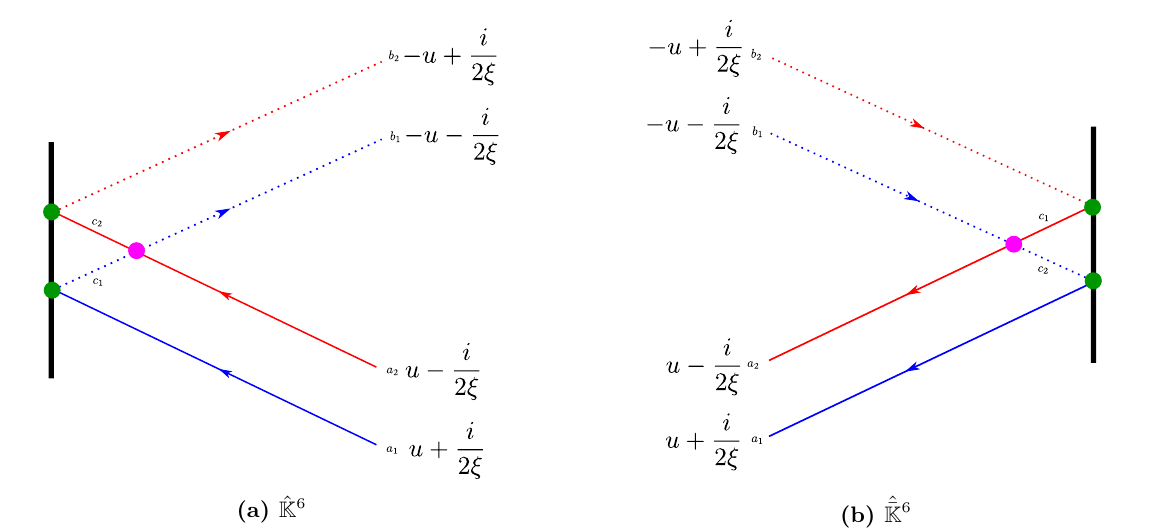
Figure 10. Boundary reflection matrices in vector representation via fusion